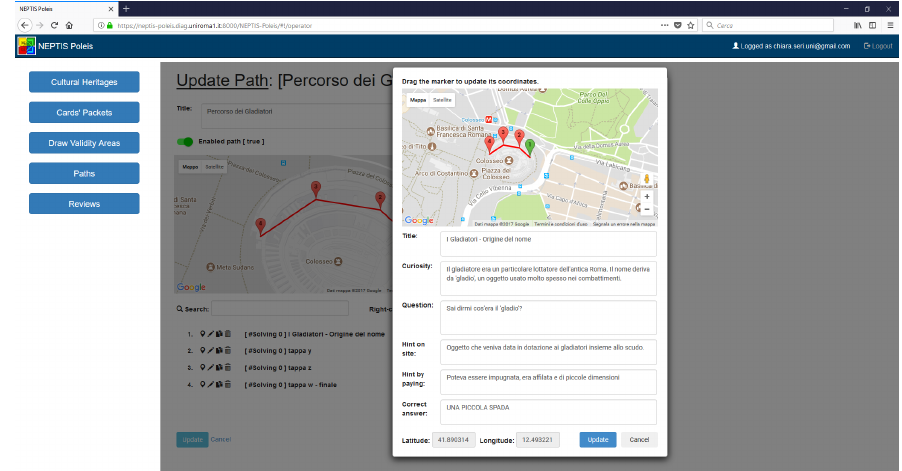
Figure 10. Enigma creation